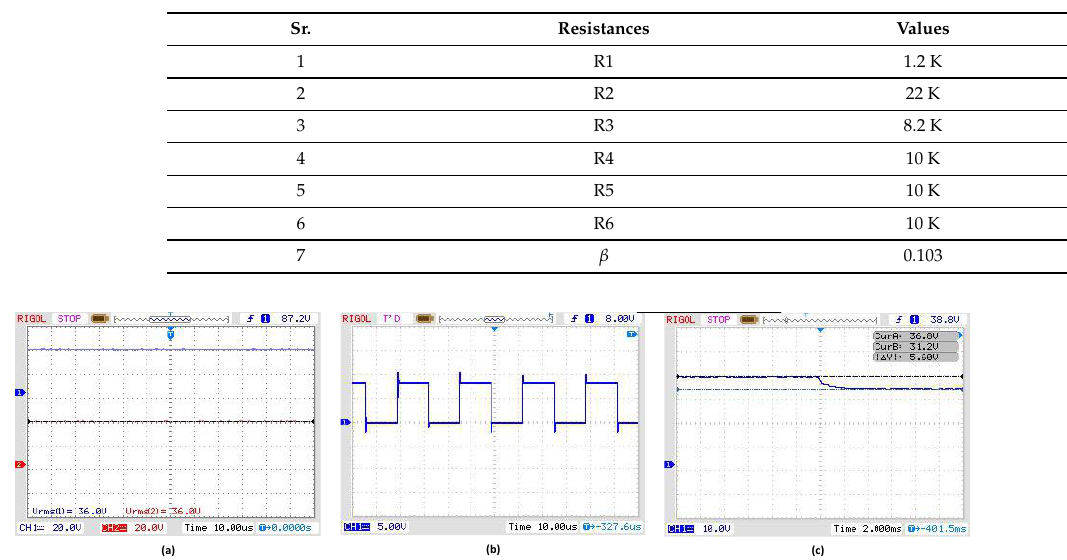
Table 2. Value of resistances.